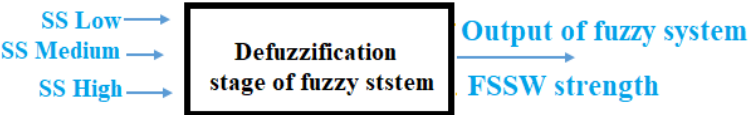
Figure 11. Defuzzification process in FSSW strength fuzzy system.